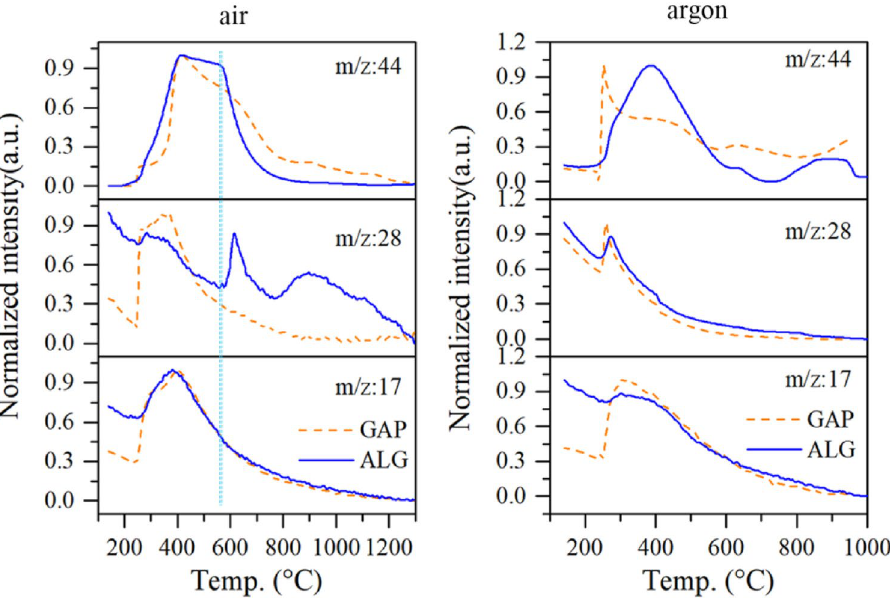
Figure 5. MS spectra of decomposition products of ALG and GAP in air and argon